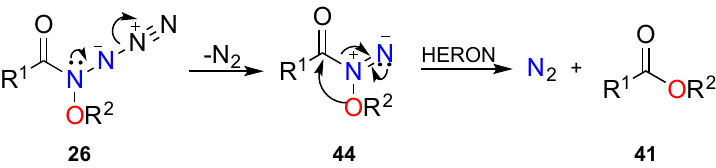
Scheme 9. Decomposition and HERON reaction of N -alkoxy- N -azidoamides 26 . Table 7. Ester 41 (R 1 COOR 2 ) formation from the reaction of N -alkoxy- N -chloroamides 25 (R 1 CONClOR 2 ) with sodium azide in aqueous acetonitrile.